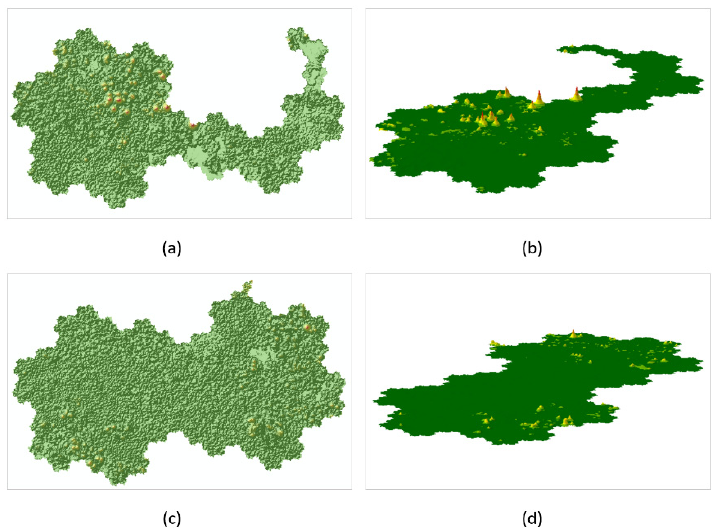
Figure 12. The two- and three-dimensional virtual terrain map results for different data sources: ( a , b ) for MyEclipse 2017; ( c , d ) for Visual Studio 2015.